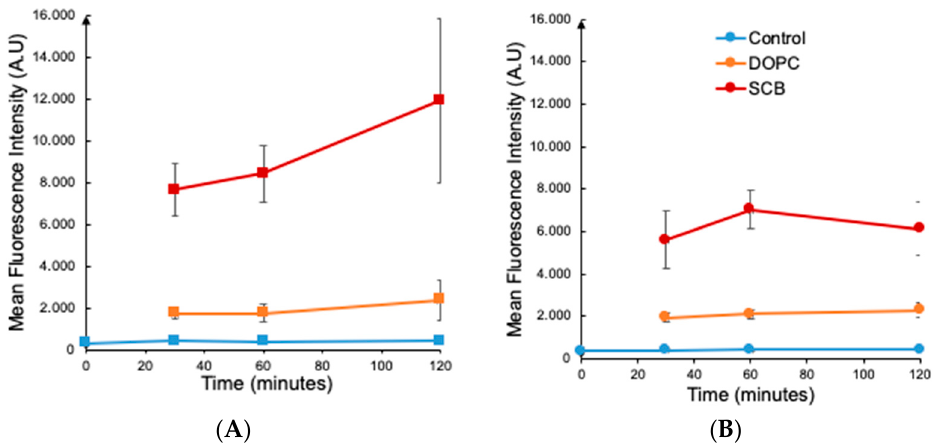
Figure 3. Uptake of SCB and DOPC liposomes measured by flow cytometry. Liposomes had 1 mol % of N-(7-nitrobenz-2-oxa-1,3-diazol-4-yl)-1,2-dihexadecanoyl-sn-glycero-3-phosphoethanolamine (NBD-PE), a fluorescent lipid that allows detection of the mean fluorescence intensity by flow cytometry. Measurements were made at 30, 60, and 120 min after coculture with the liposomes. Measurements of the average of six independent experiments are shown, and the data are shown as the mean and standard error ( n = 6). ( A ) Astrocytoma cell liposome uptake; ( B ) neuroblastoma cell liposome uptake.